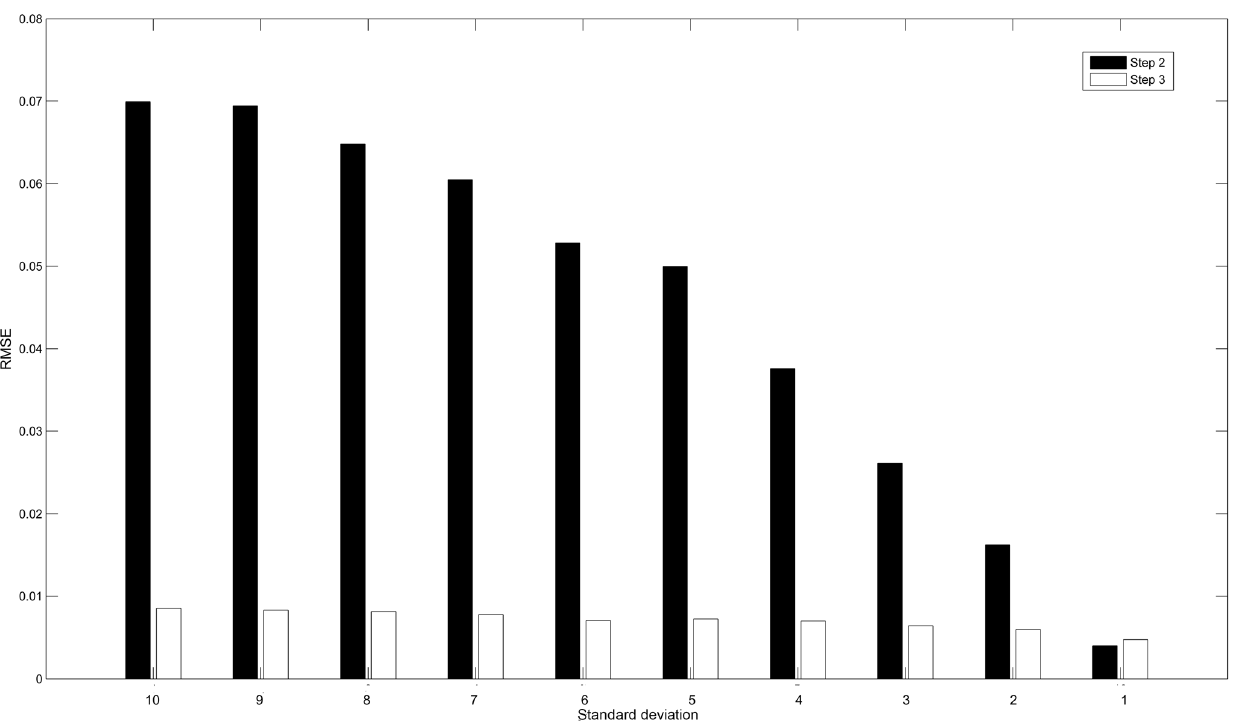
Figure 9. Relationship between noise levels and RMSE. This chart shows the RMSE values for inferred transition matrices of n-39 network under 6 perturbations at different noise levels. The standard deviations of noises vary from 10 to 1. In Step 2, the RMSE values range from 7 : 0 | 10 { 2 to 4 : 0 | 10 { 3 ; in Step 3, the RMSE values range from 8 : 5 | 10 3 { to 4 : 7 | 10 3 { .